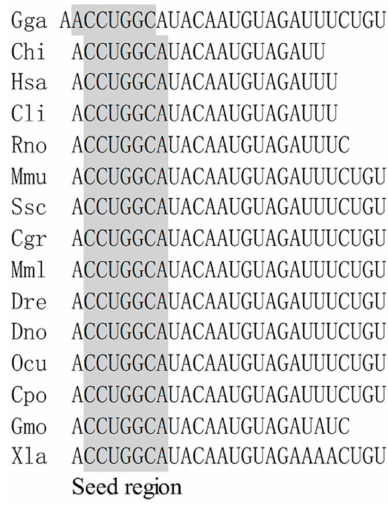
Figure 1. Alignment of miR-221-5p mature sequence among species. Note: Gga: Gallus gallus ; Chi: Capra hircus ; Has: Homo sapiens ; Cli: Columba livia ; Rno: Rattus norvegicus ; Mmu: Mus musculus ; Ssc: Sus scrofa ; Cgr: Cricetulus griseus ; Mml: Macaca mulatta ; Dre: Danio rerio ; Dno: Dromaius novaehollandiae ; Ocu: Oryctolagus cuniculus ; Cpo: Crocodylus porosus ; Gmo: Gadus morhua ; Xla: Xenopus laevis .